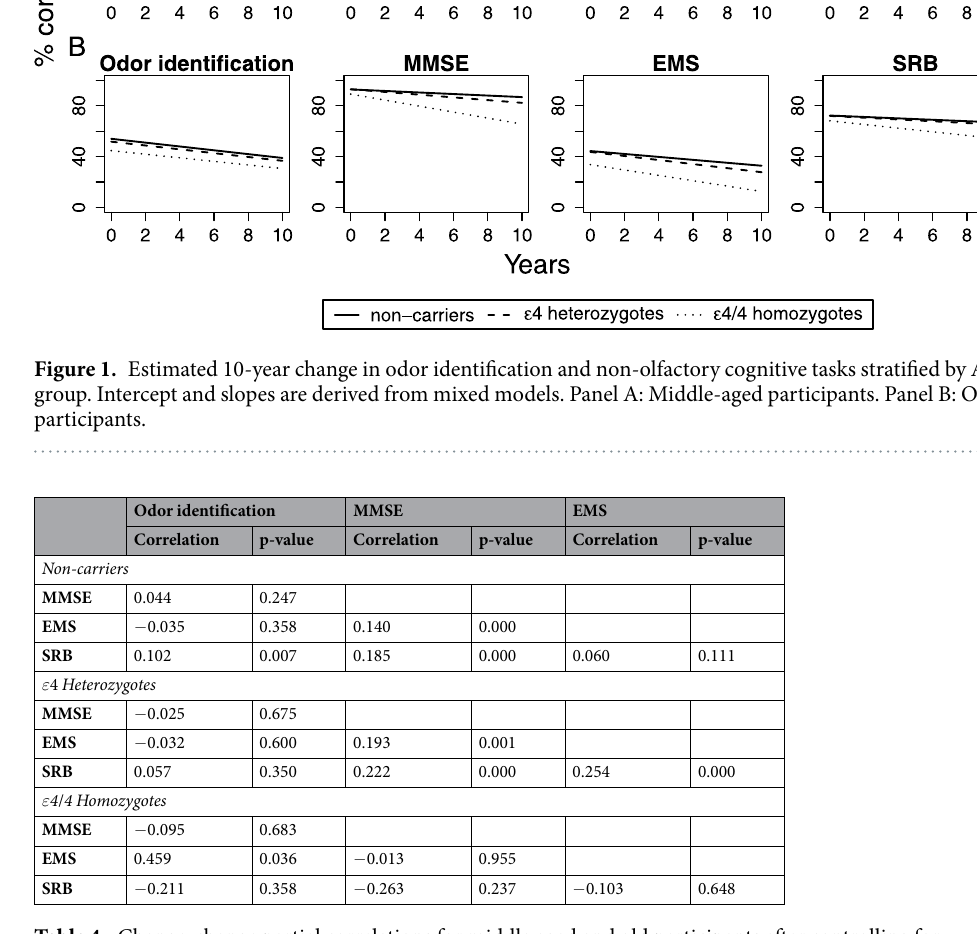
Table 4. Change-change partial correlations for middle aged and old participants after controlling for demographic covariates; age, sex, education, and an indicator variable to account for potential effects related to previous testing experience (one vs. two